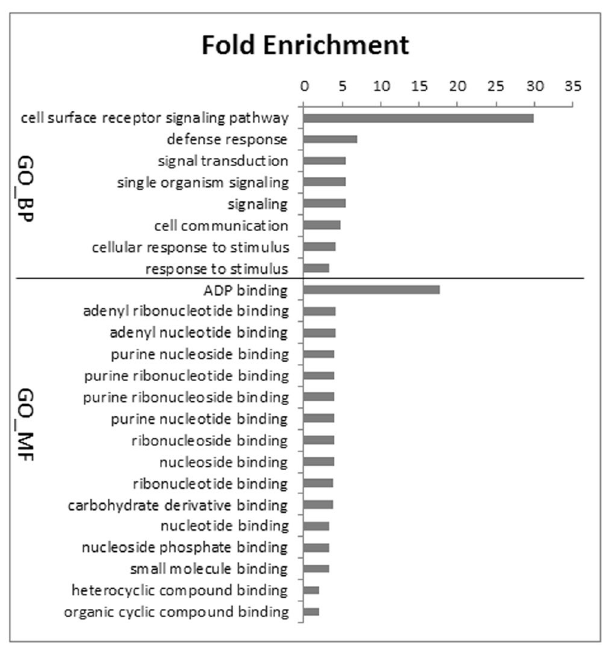
Figure 5. GO functional enrichment analysis of the target genes of B. cinerea -responsive